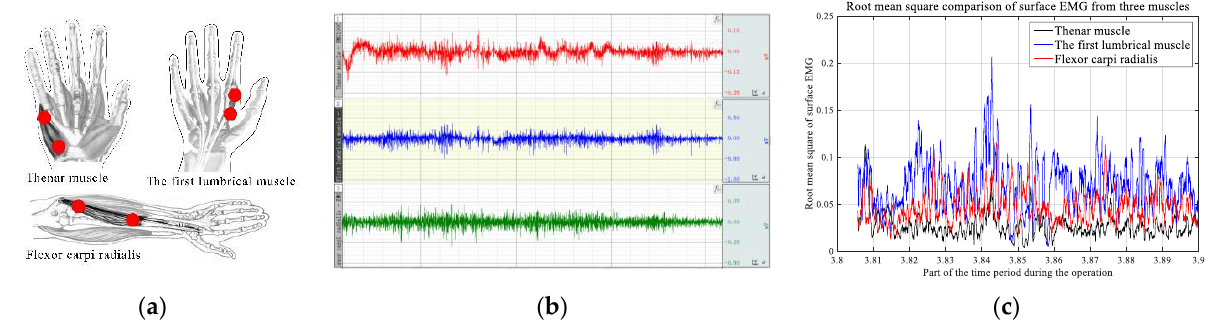
Figure 12. Surface EMG acquisition experiment. ( a ) Electrode positions on the right hand. ( b ) Original EMG signal. ( c ) RMS value of surface EMG.